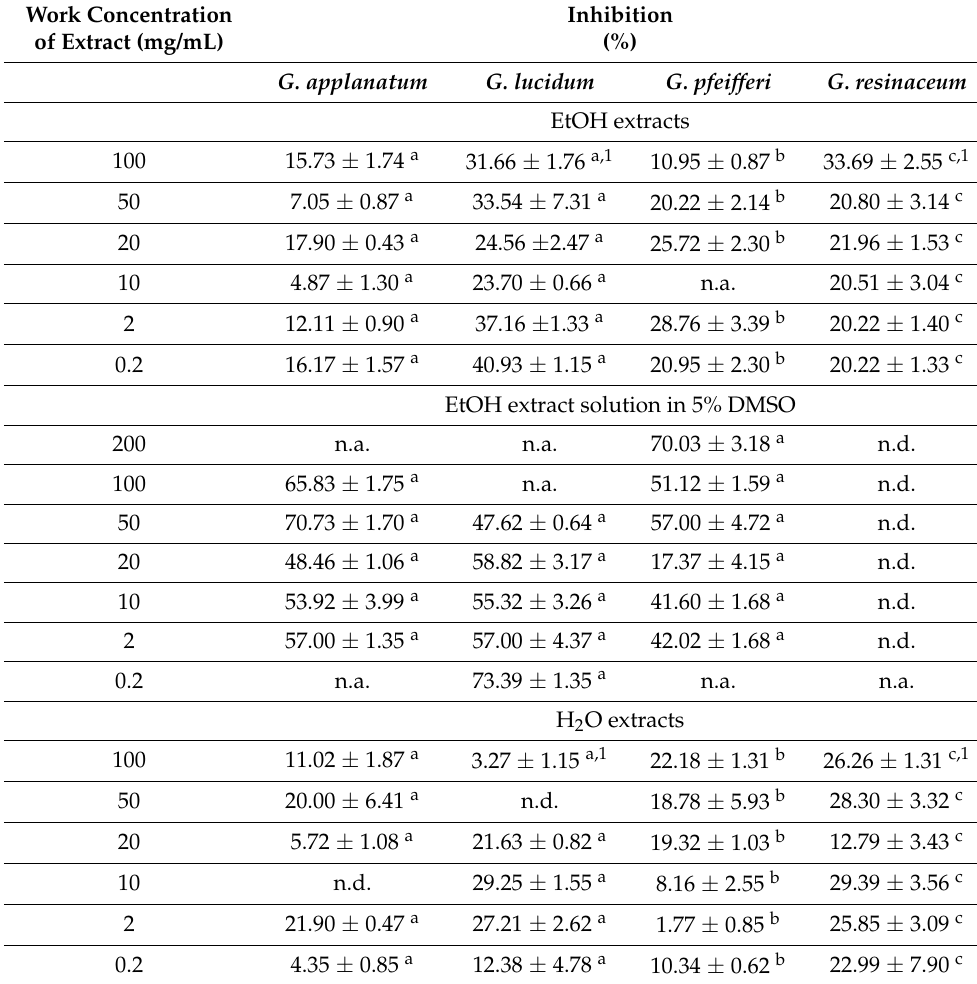
Table 4. Inhibition of growth of vB_BbrS_LK3 virus by G. applanatum , G. lucidum , G. pfeifferi and G. resinaceum